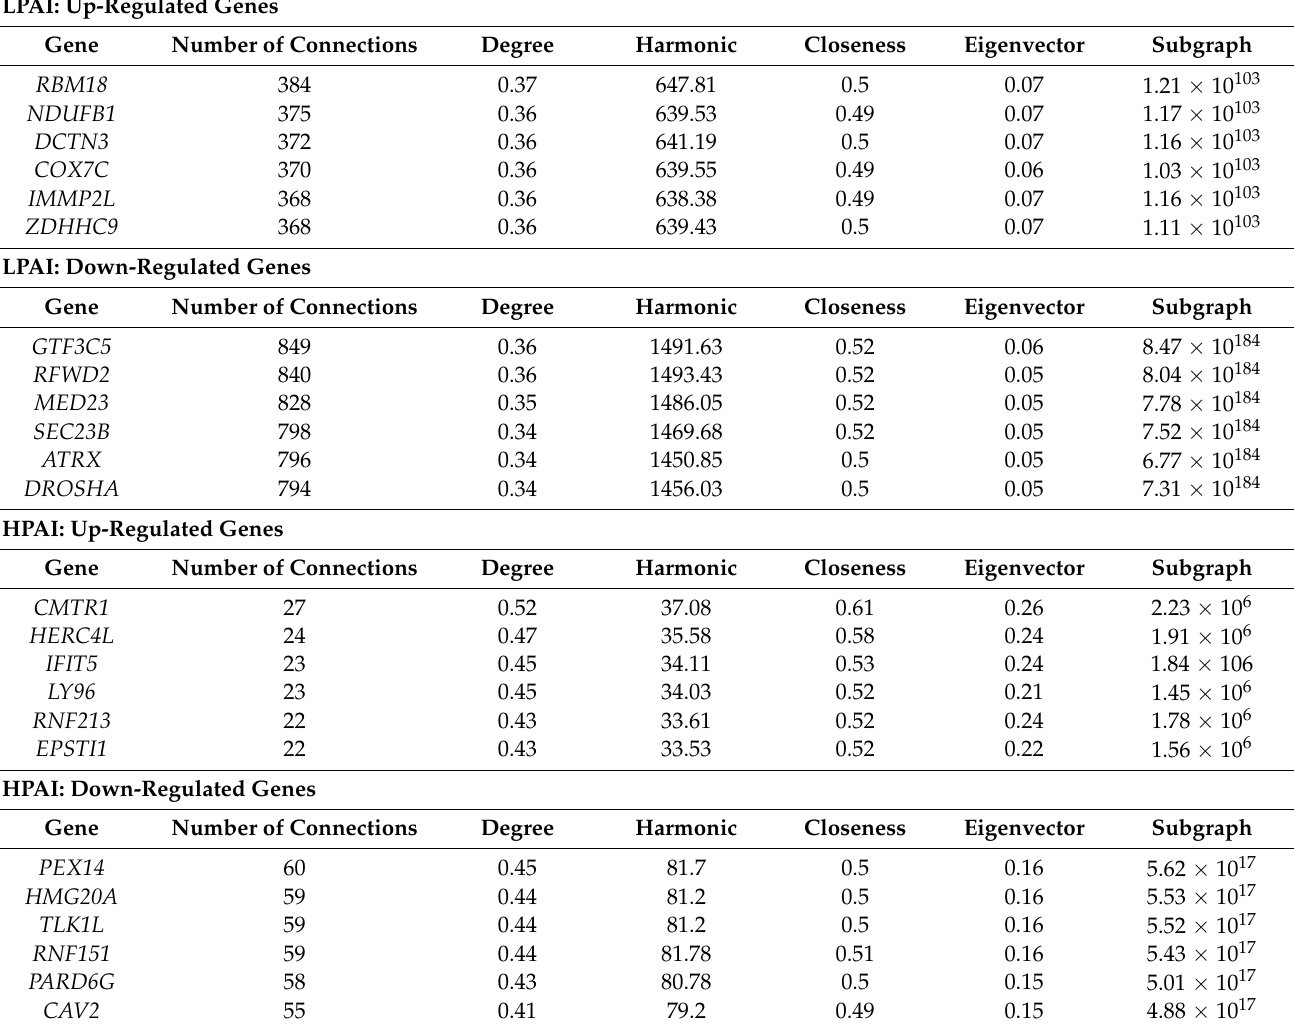
Table 2. Top 6 hub genes identified from each network